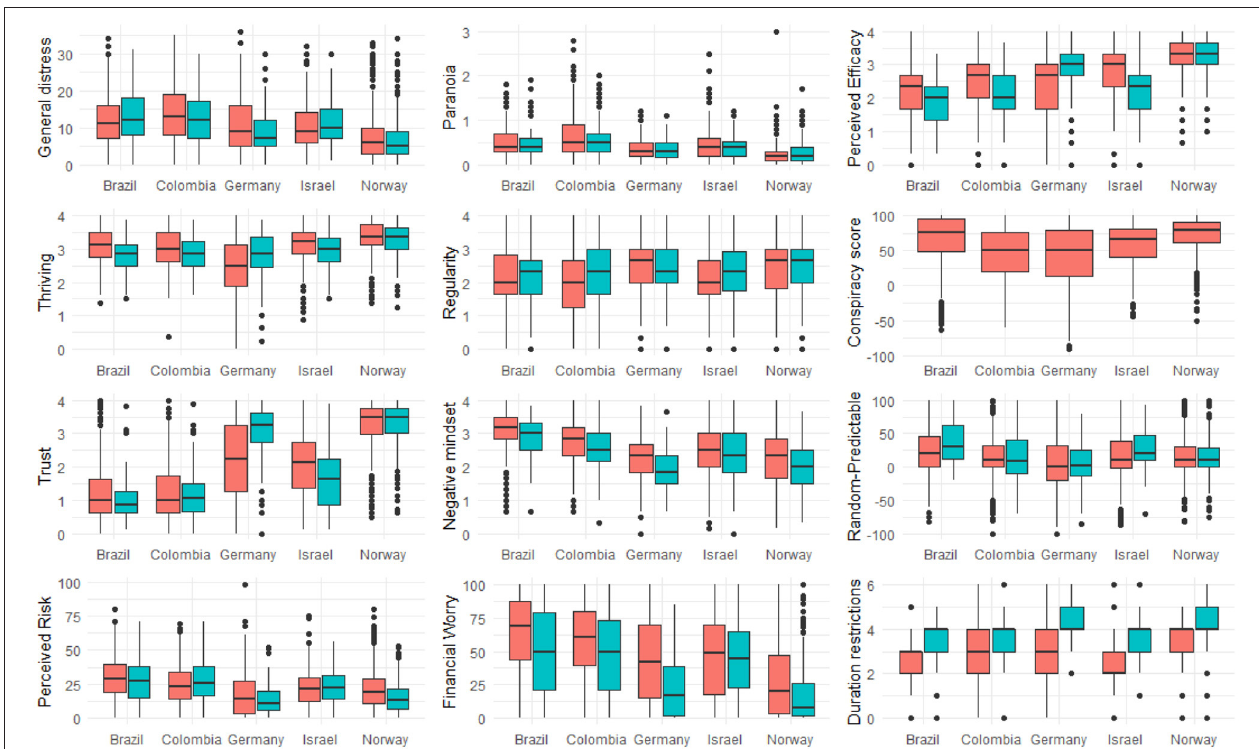
FIGURE 1 | Boxplots indicating the median, second and third quartiles and outliers for the dependent and independent measures included in our study. Red = April data, Blue = July data. No data are available for conspiracy theories in July as we omitted this scale. For statistical details see Supplementary Material , page